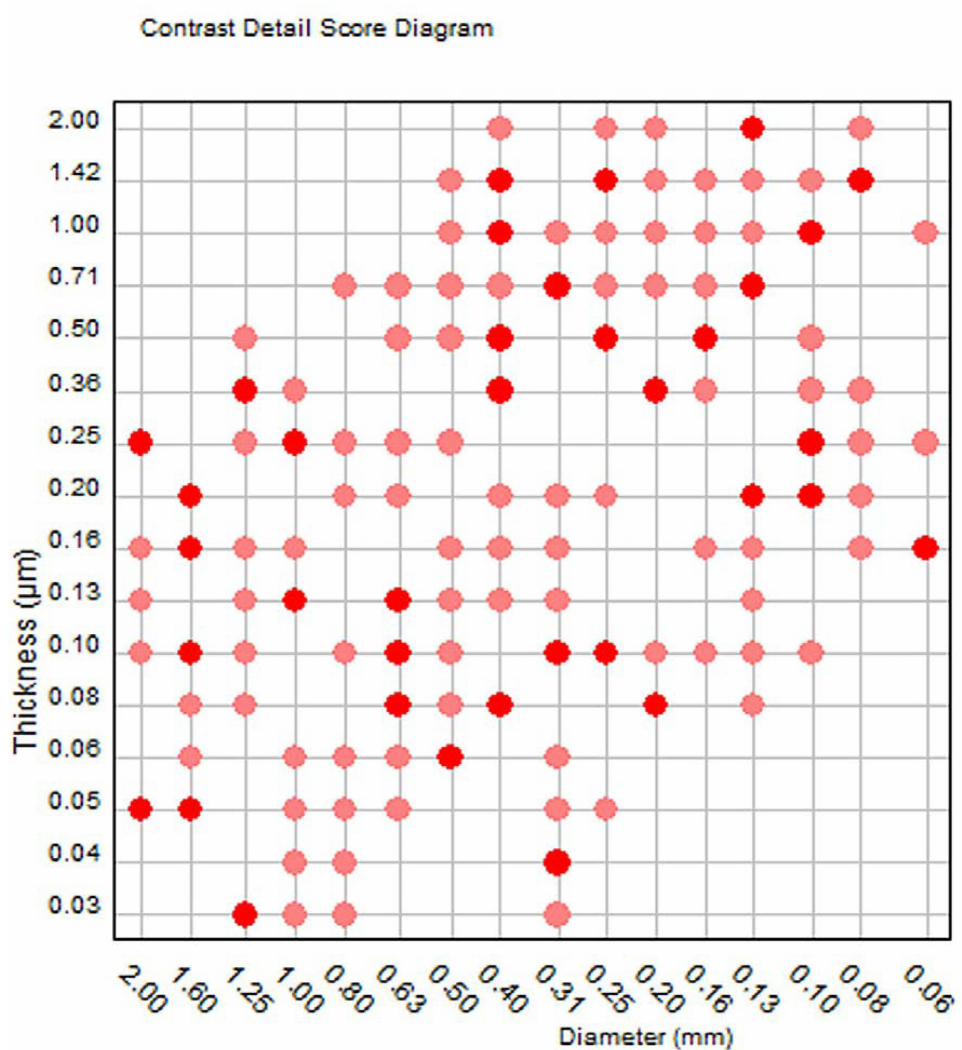
Figure 6. An example of erratic contrast–detail score diagram output obtained for TL22 images obtained with H-mode (HR) operation mode (output of the CDMAM3.4 Analyser software). It can be seen that larger and thicker disks are not detected but smaller and thinner disks